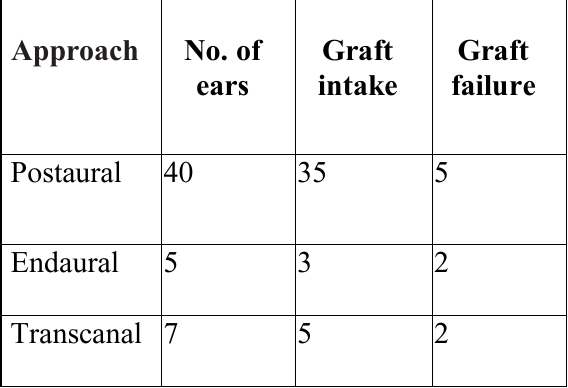
Table 5: Surgical approach